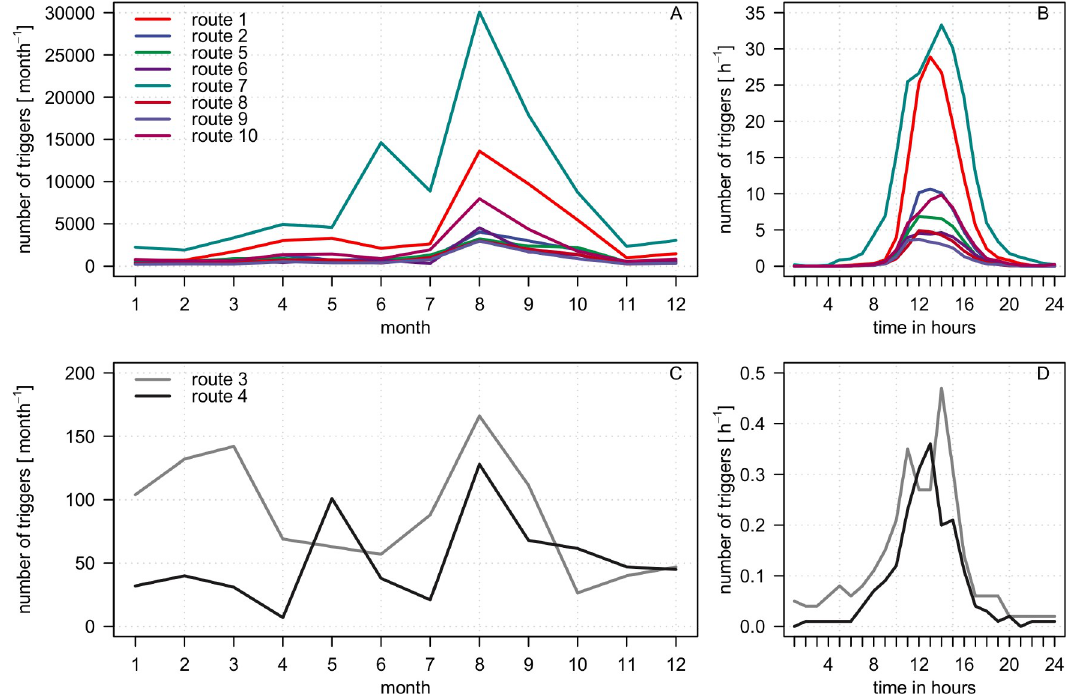
Fig 2. Seasonal and diurnal human activity on public and closed routes. Mean numbers of trigger events are averaged per month and per hour for public routes (A and B) and closed routes (C and D).